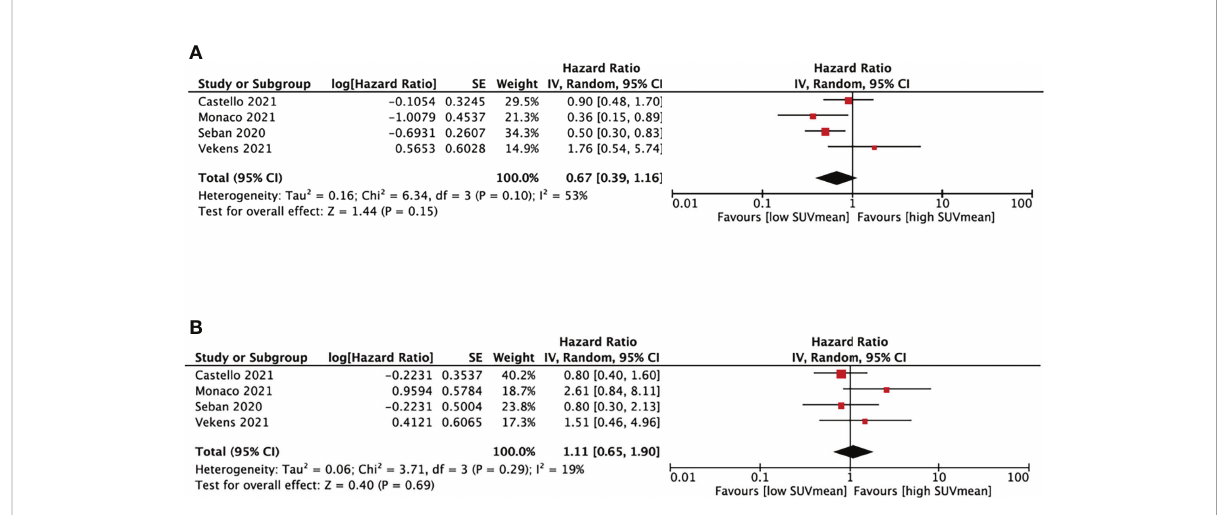
FIGURE 4 Forest plots of hazard ratios comparing progression free survival (A) or overall survival (B) of patients with high level versus low level mean standardized uptake value treating with immune checkpoint